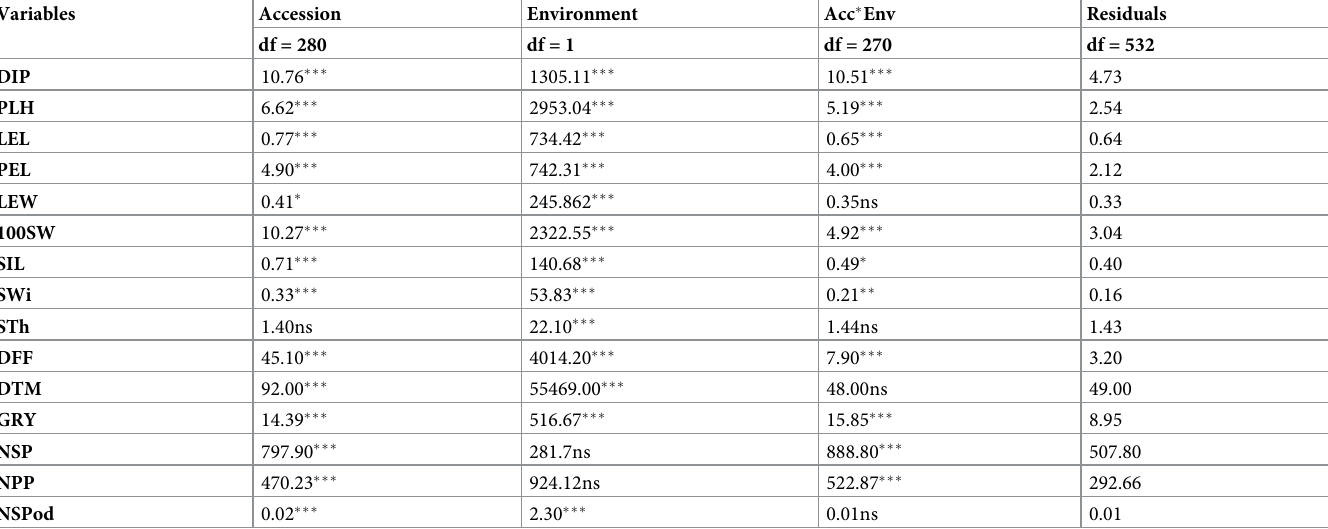
Table 3. Mean squares of analysis of variance of morphological traits among Kersting’s groundnut accessions across Se´kou and Sav è environments.